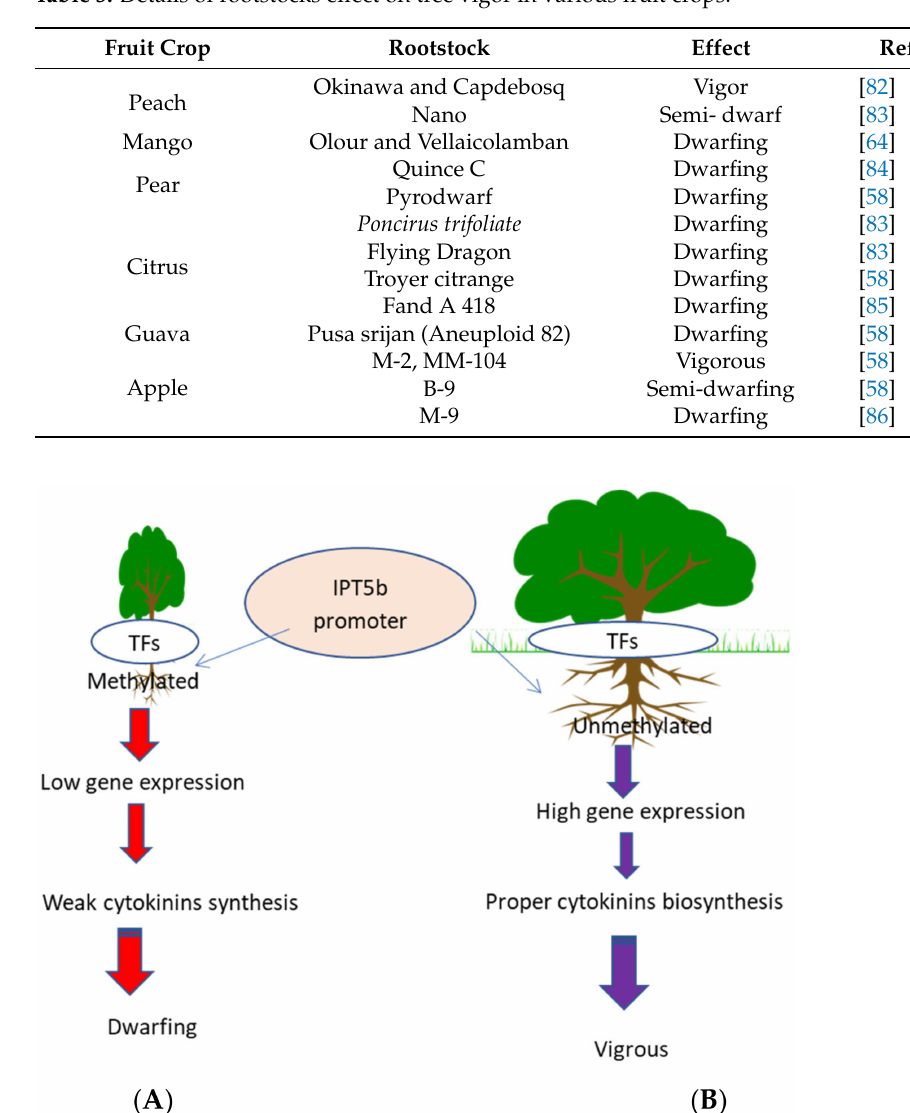
Figure 3. Effect of differential gene expression to regulate canopy of fruit plant. This figure well explains how methylated ( A ) and unmethylated ( B ) condition regulate the plant height along with concentration of cytokinin. DNA methylation are epigenetic marks and are highly conserved and involved in altering the canopy of the plants by catalyzing changes in the chromatin structure through methylation and demethylation. Cytosine methylation (5 mC) is the key regulator in